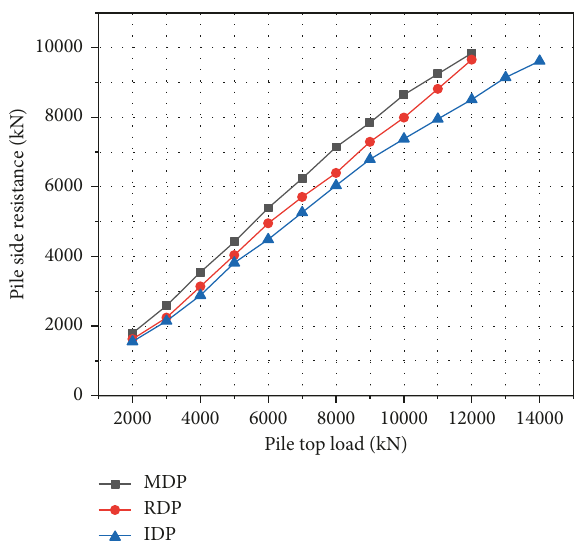
Figure 14: Pile side resistance of test piles under various loads.